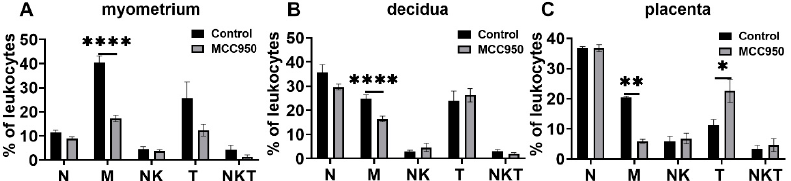
Figure 9. Effects of MCC950 treatment on leukocyte subsets in gestational tissues at term labor. Pregnant mice were administered MCC950 (i.p.) at GD18.5. The mice with MCC950 treatment were sacrificed at the onset of labor. The control mice were administered the same volume of saline and sacrificed at the onset of labor. Myometrium, decidua, and placentas were obtained for determination of neutrophils, macrophages, NK, T cells, and NKT cells by flow cytometry analysis. ( A ) Populations of leukocyte subsets in myometrium; ( B ) populations of leukocyte subsets in decidua; ( C ) populations of leukocyte subsets in placenta. Data are expressed as mean ± SEM. n = 6 in each group. * p < 0.05, ** p <0.01, **** p < 0.0001. N, neutrophils; M, macrophages. creased macrophage infiltration in the myometrium and placenta at the time of preterm